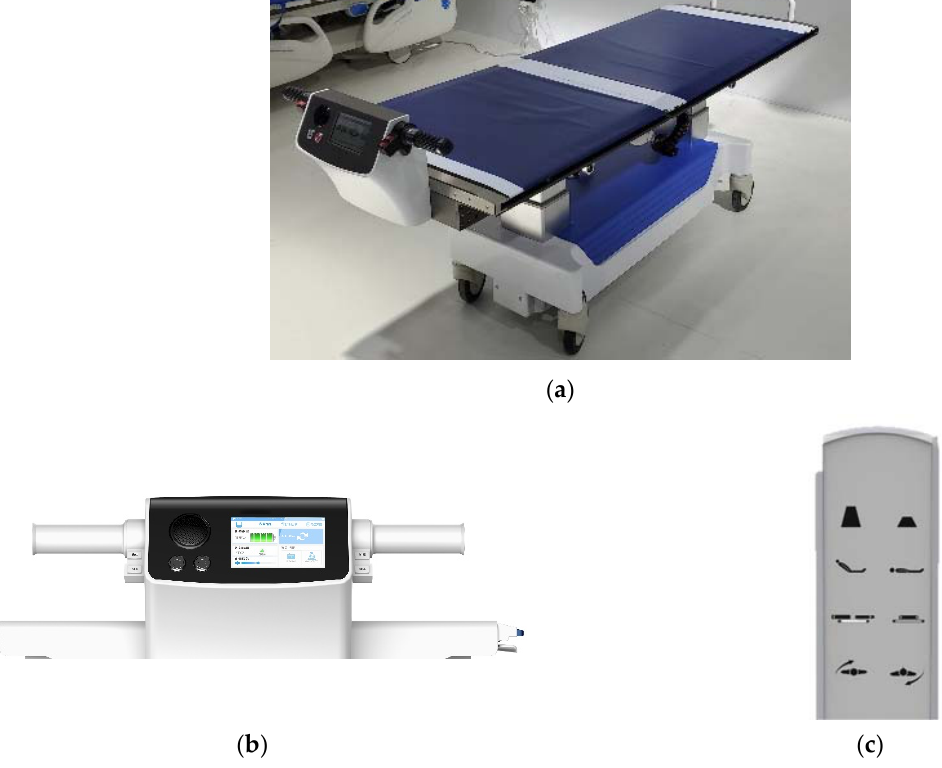
Figure 17. Prototype of the patient transfer robot. ( a ) Body of the patient transfer robot; ( b ) touch-screen control; ( c ) remote control.